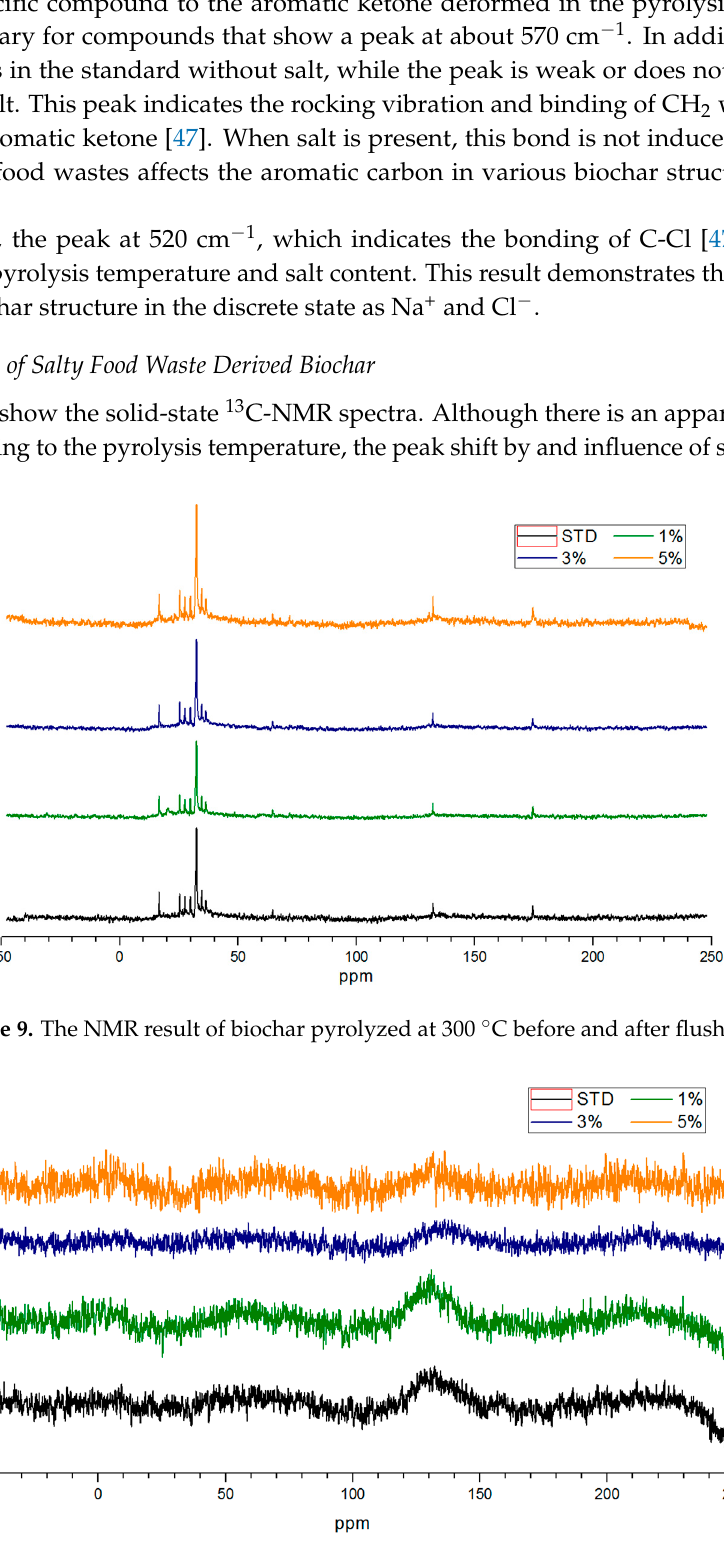
Figure 10. The NMR result of biochar pyrolyzed at 400 °C before and after flushing.